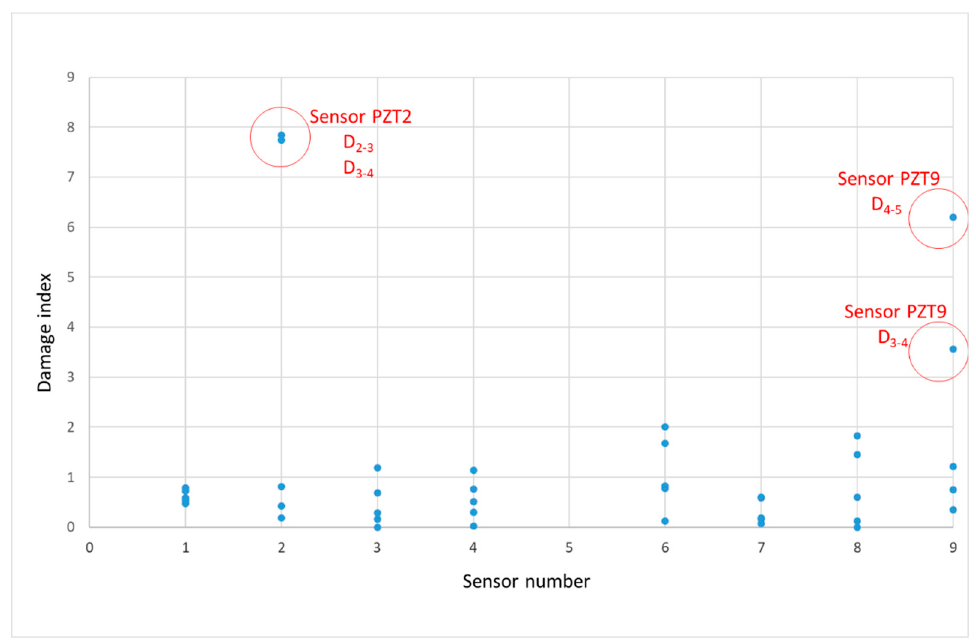
Figure 11. Damage index—beam A.